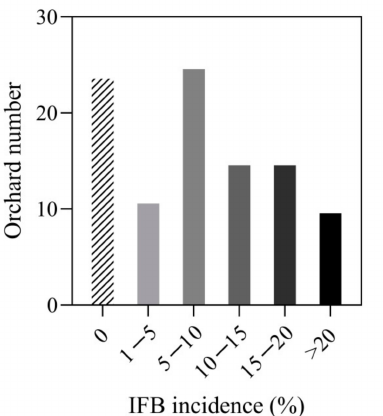
Figure 4. The distribution of IFB incidence evaluated in 100 mango